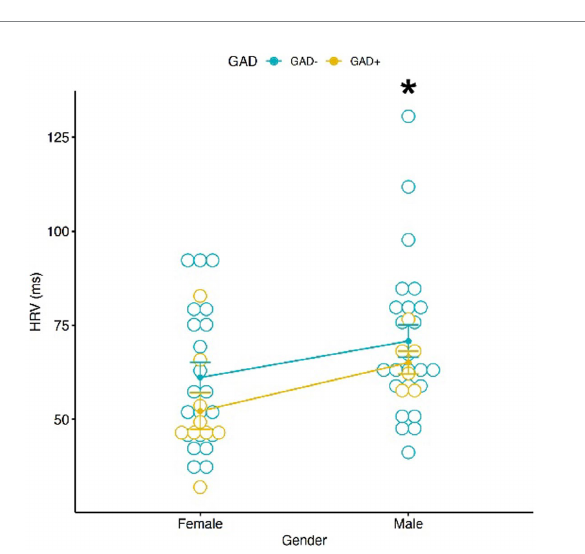
FIGURE 3 Graphic distribution of HRV values during the 3 conditions according to GAD